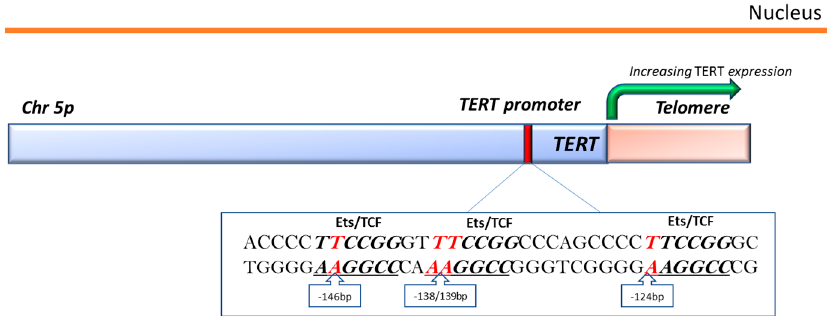
Figure 3. Schematic representation of TERT promoter structure. TERT promoter region (red bar) and TERT gene (pink bar). Core consensus sequence with Ets/TCF regulatory elements of TERT promoter and location of BCC-specific mutations (red) are reported in the box. The Ets/TCF binding motifs for Ets/TCF transcription factors created by mutations are underlined. TERT , telomerase reverse transcriptase; Ets/TCF; Ternary complex factor (TCF) subgroup of the Ets E26 transformation-specific transcription factor.